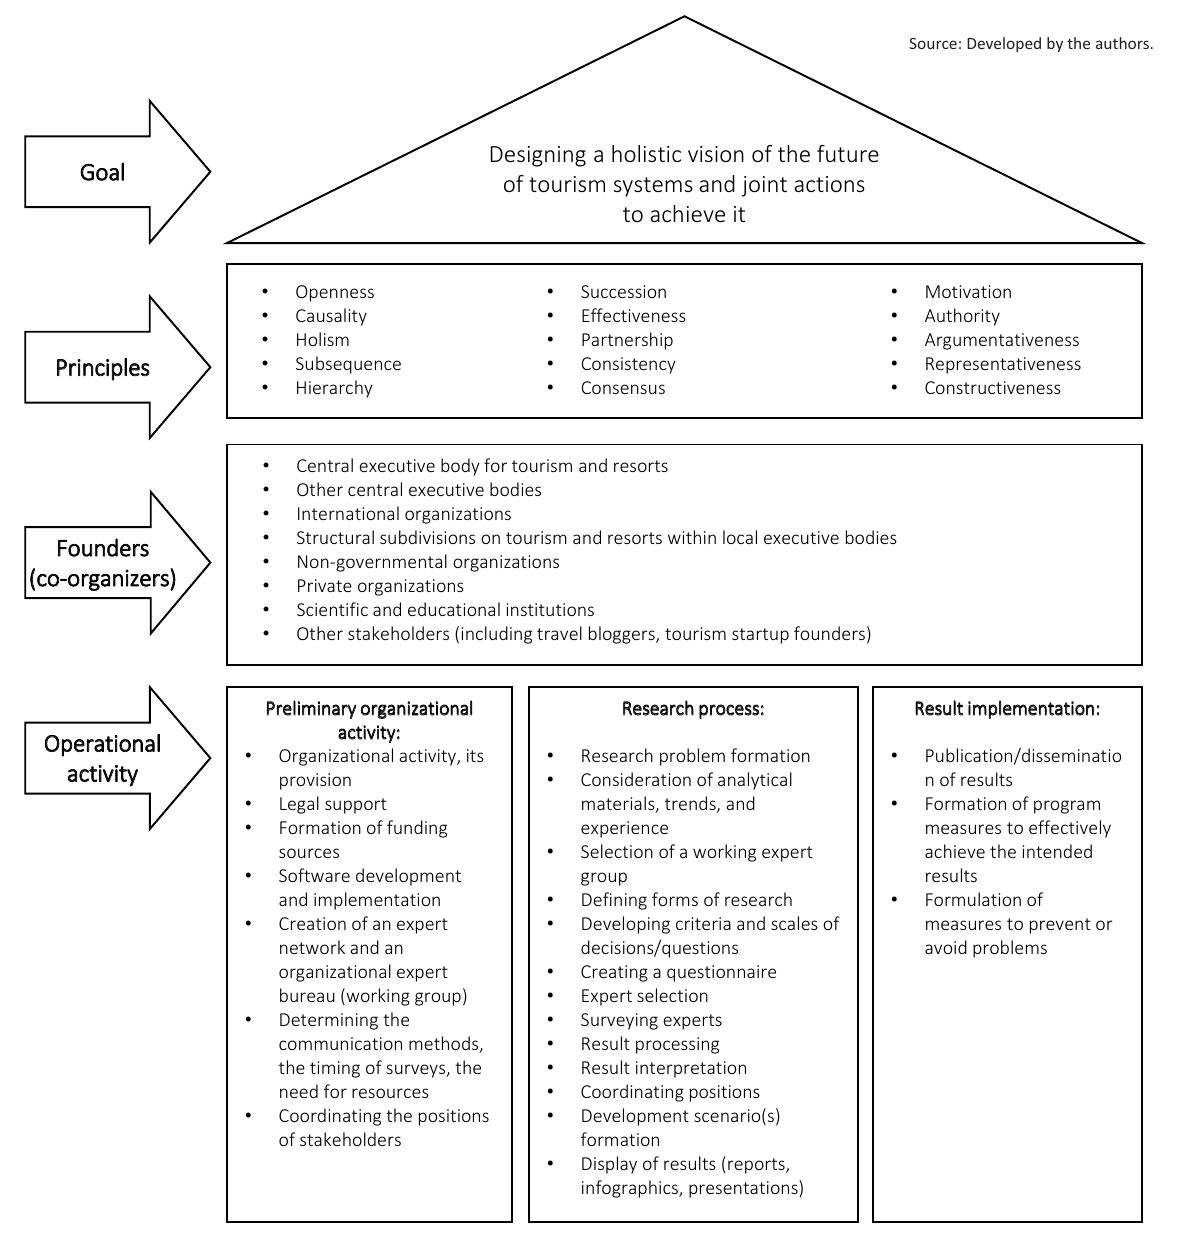
Figure 1. Architectonics of the foresight platform of Ukraine’s tourism